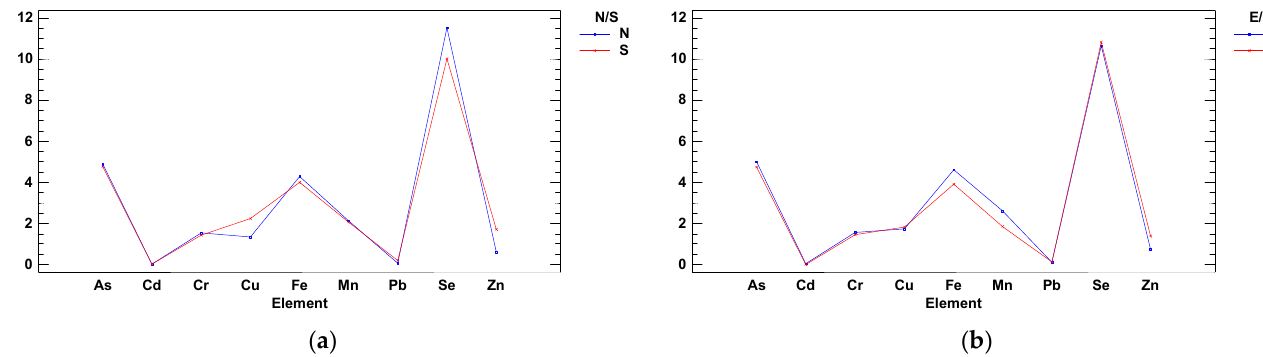
Figure 2. Two-way ANOVA interactions amongst elements and cardinal axis {level at μ g L –1 (y axis) vs. elements (x axis)}: ( a ) N/S, with Cu and Zn higher levels in the south (Vigo harbor) and ( b ) E/W, with Mn and Fe higher levels in the east (inner estuary).